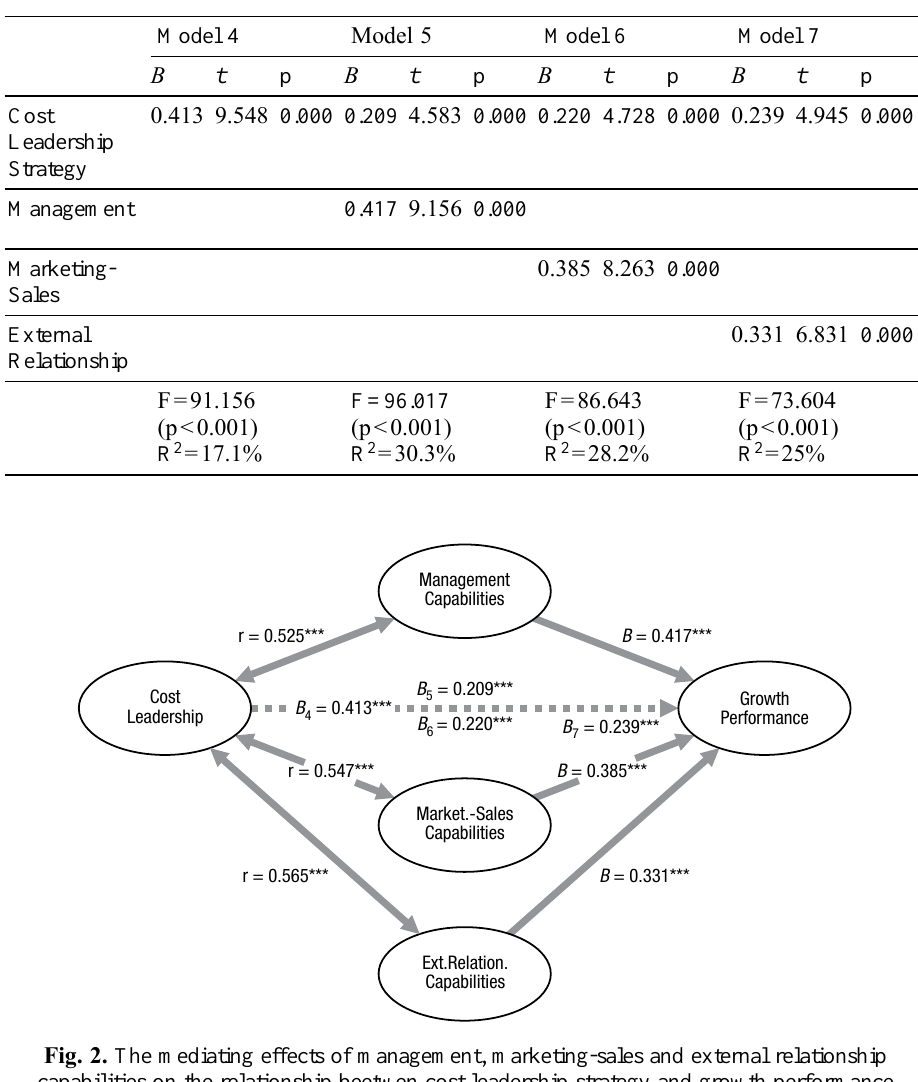
Table 8. The total effects of cost leadership strategy, management, marketing-sales